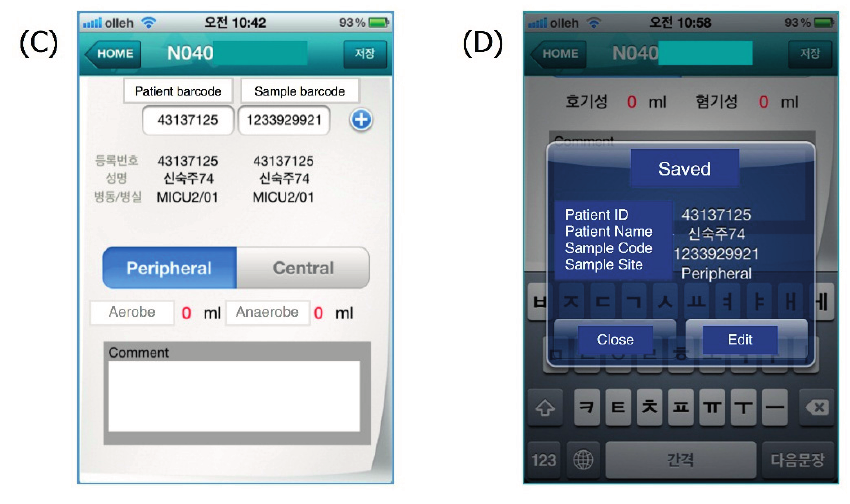
Figure 3. “Blood Culture” application. ( A ) Barcode reading menu; ( B ) Barcode